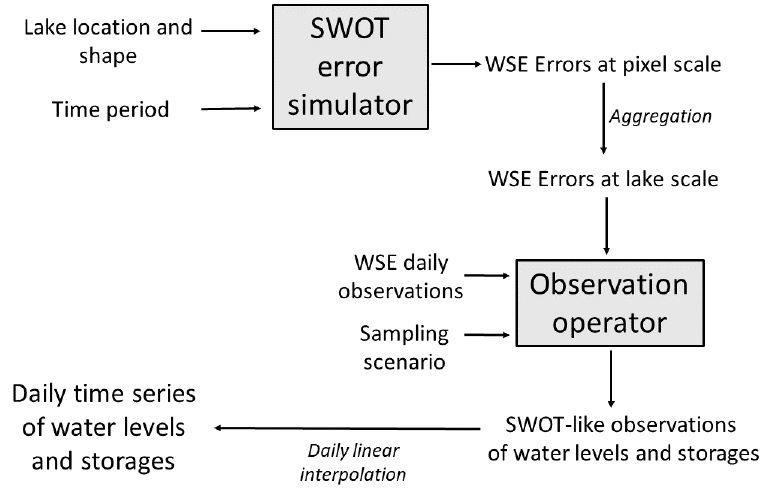
Figure 5. Methodology workflow used to generate the daily time series of water levels and storages for the reservoirs and gravel pits studied.